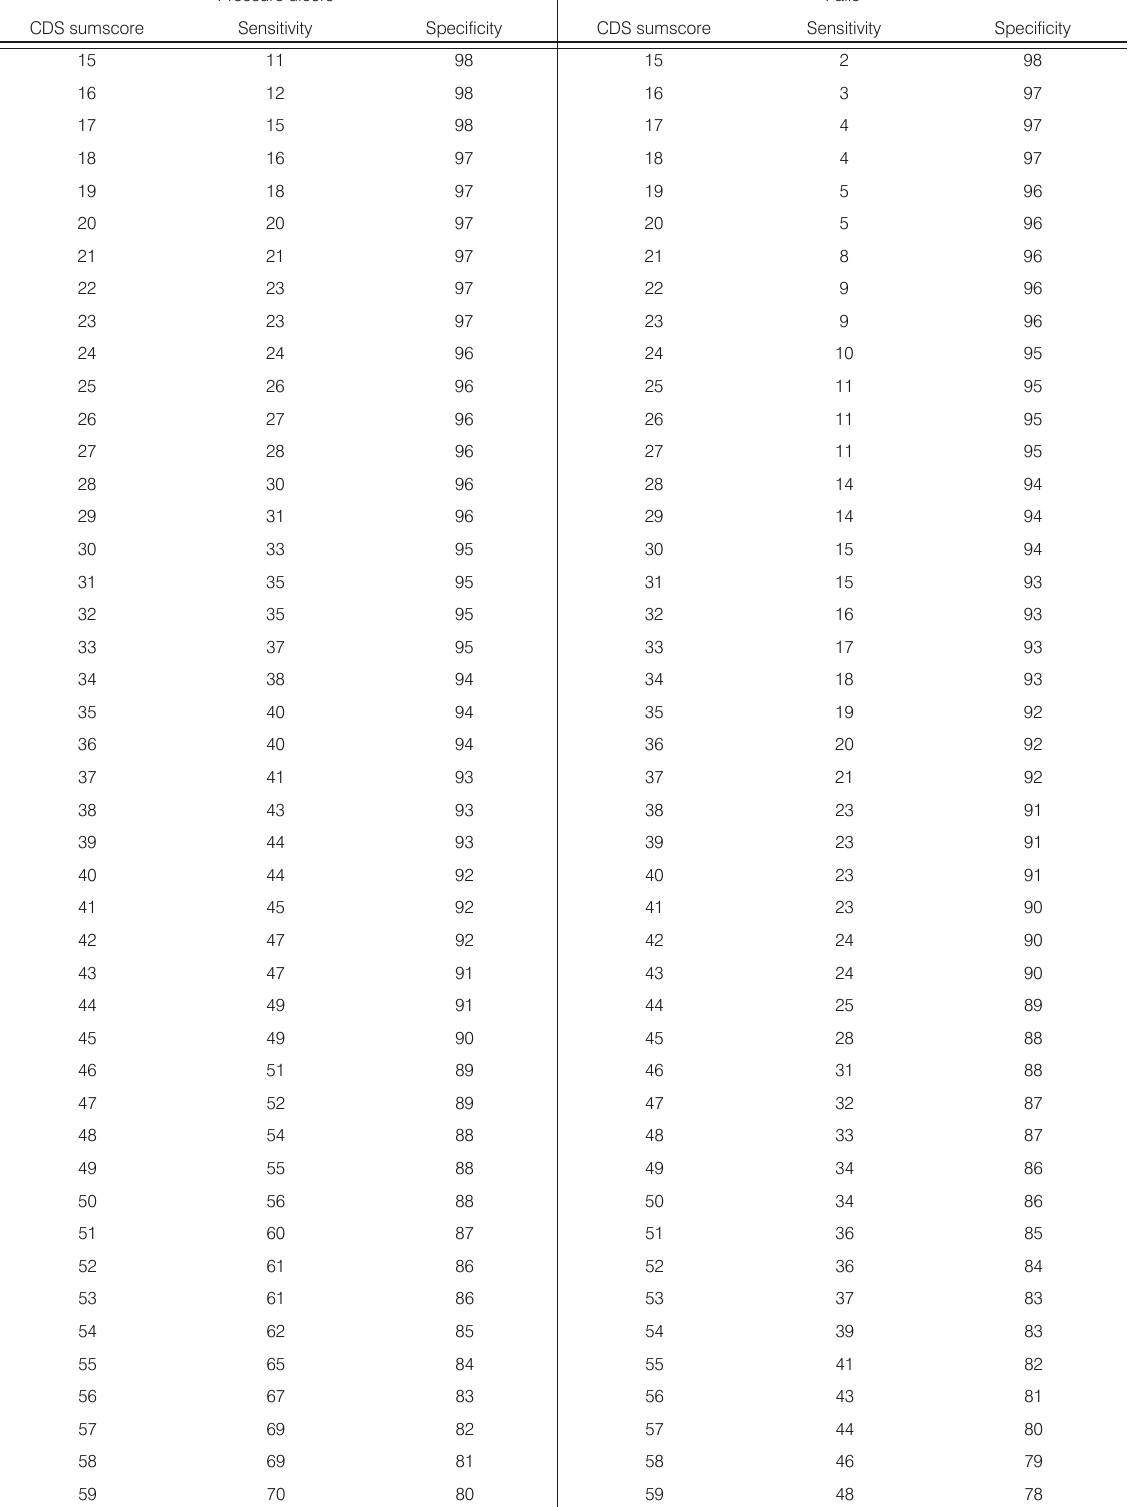
Table 3. Sensitivity and specificity values (%) of all CDS sumscores for pressure ulcers and